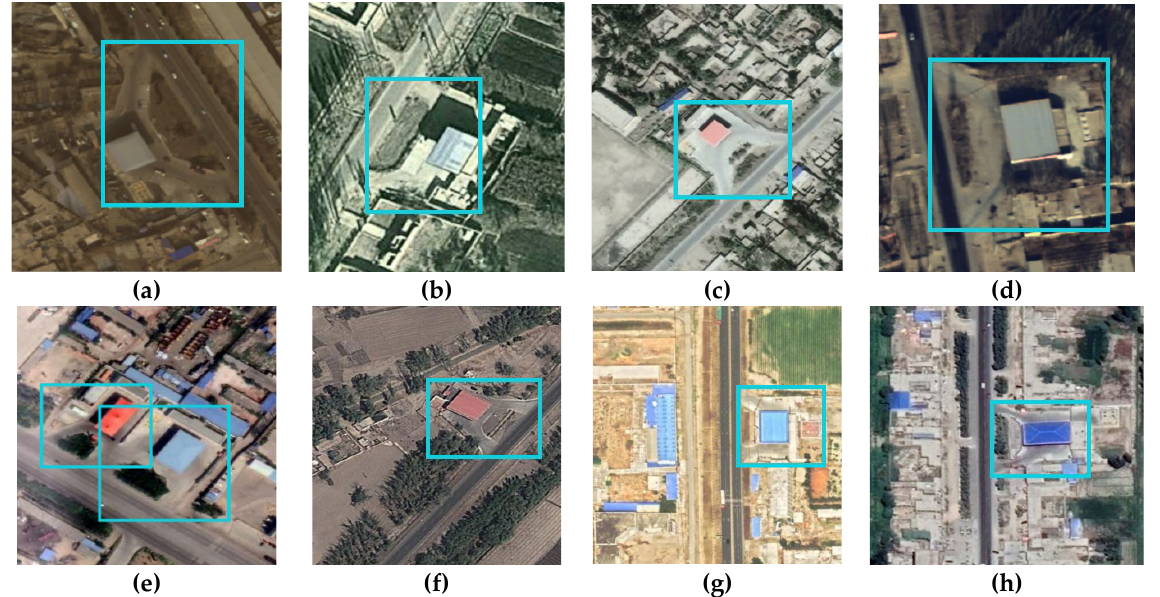
Figure 2. Examples of images and label frames of the GS dataset: ( a )–( d ) are gas station data with different image qualities from remote sensing images provided by the funded project and ( e )–( h ) are gas station data with varying image qualities from Google Maps. The blue boxes are the label frames.